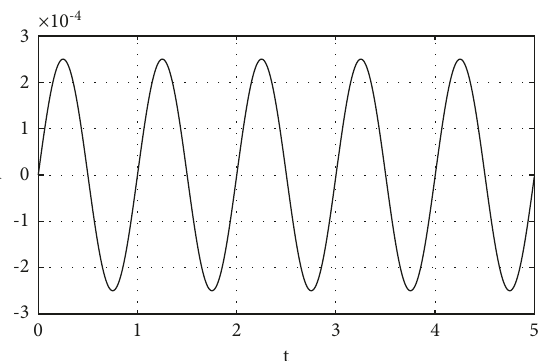
Figure 6: Phase portraits of system (4a–4c) in planes ( x,y ) for specific value of T (e) T 3 � 0.045, and (f) T 3 � 0.1148. Initial conditions are (0.01, 0.01, 20) the system parameters are c � 30; u � 0.009; β � 0.03; v � 0.005; σ � 1.65. We can see that the phase portraits (b) and (f) display intermittency behavior.